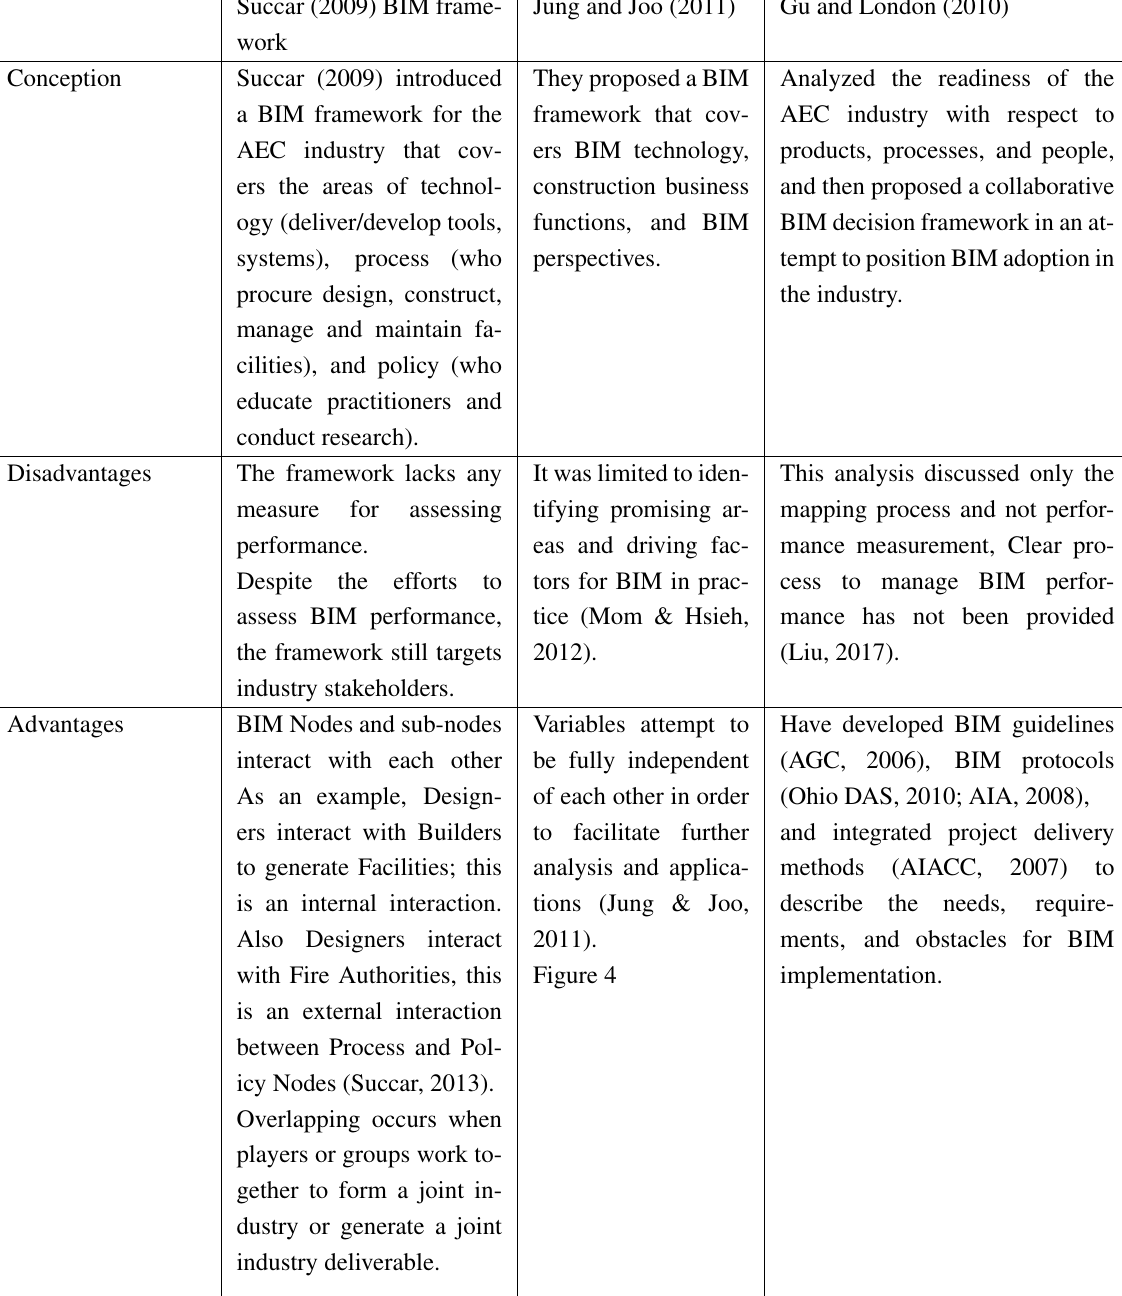
Table 2. Comparison between different BIM